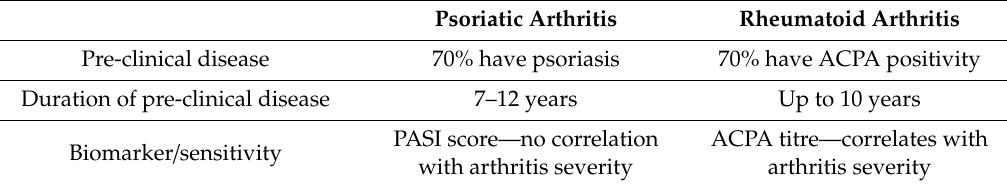
Table 1. Pre-clinical markers in early arthritis—psoriatic arthritis versus rheumatoid